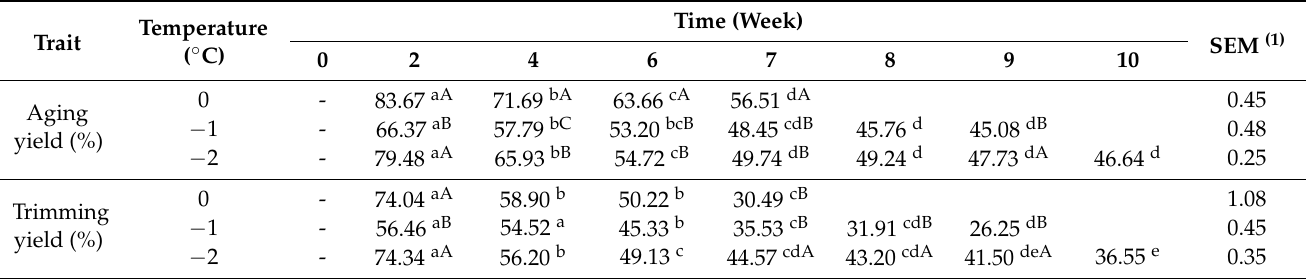
Table 1. Aging yield and trimming yield of dry-aged beef loin on 0, − 1, − 2 ◦ C temperature electric field refrigerate system.